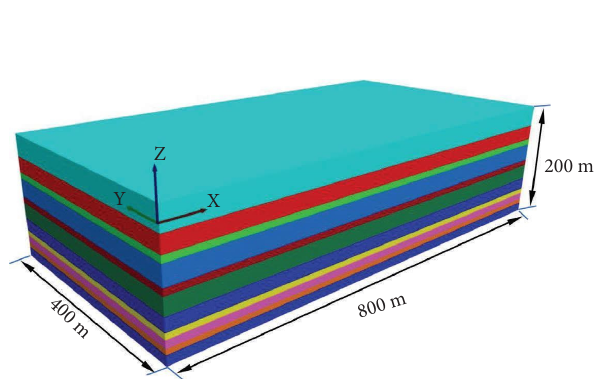
Figure 2: Numerical